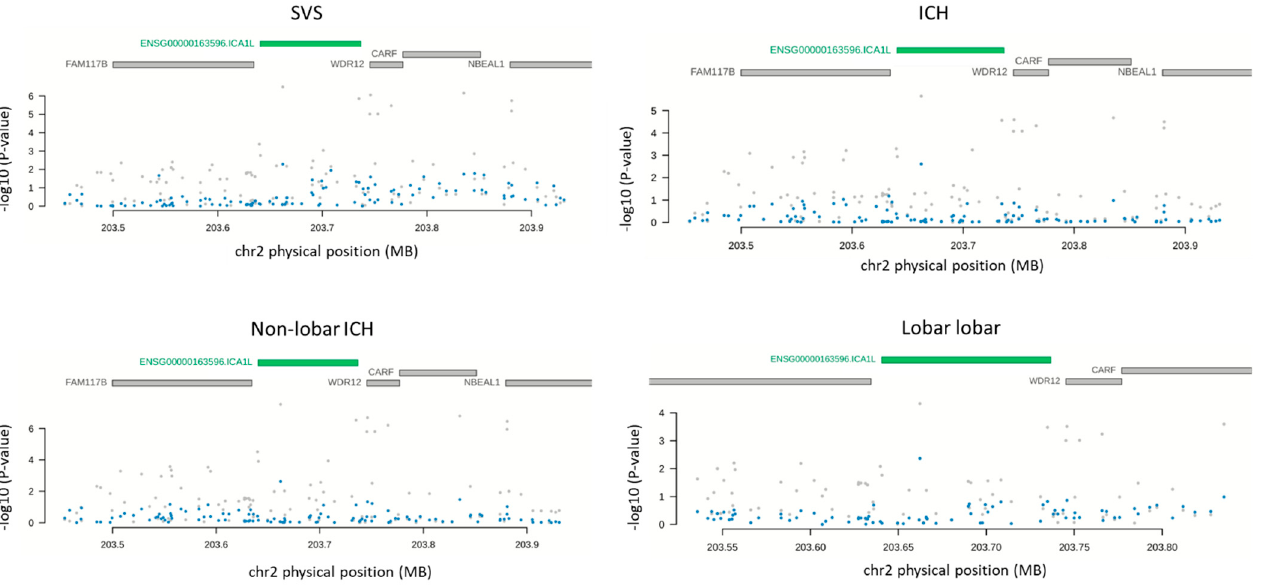
Figure 2. GWAS results before conditioning by ICA1L levels (grey) or after conditioning by protein levels (blue).